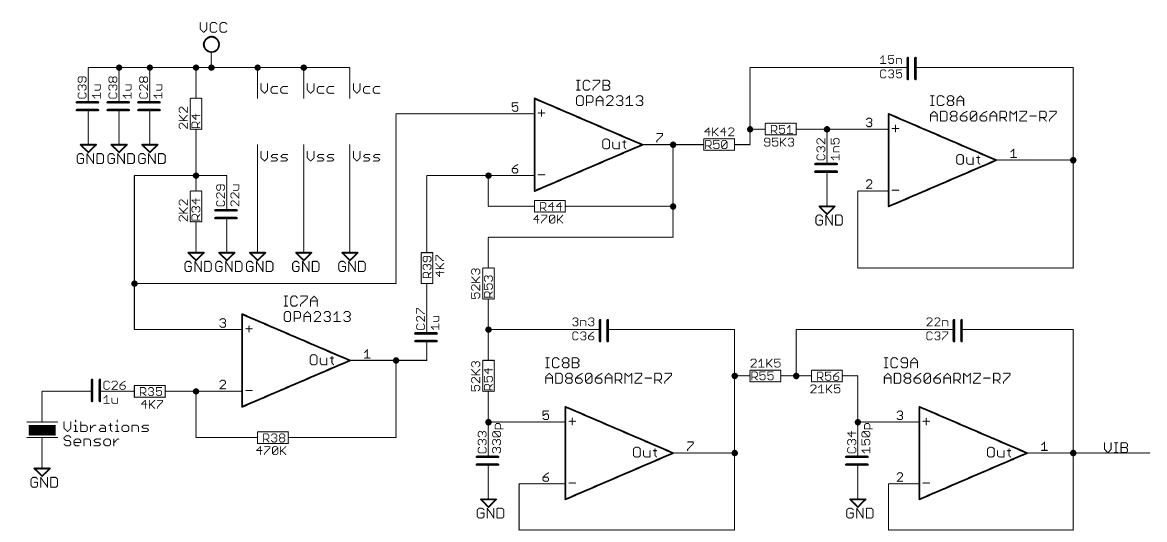
Figure A8. The schematic of the piezoelectric sensor amplifier. Amplifies the sensor's output voltage microvariations (BeStar FT-35T-2.6A1), filtered with a 4KHz low pass filter whose output leads the analog input to the processor.